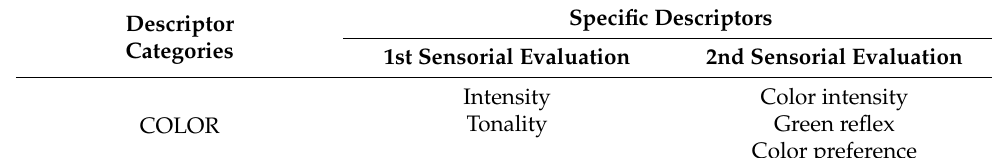
Table 3. Descriptors of sensorial